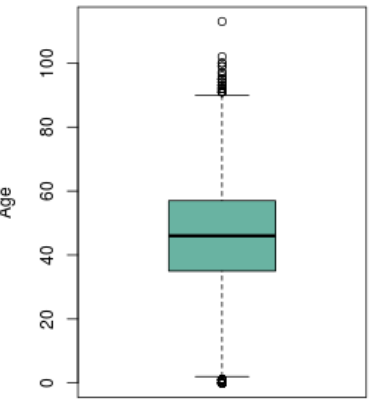
Figure 5. Boxplot of the distribution by age the population from all the territory with positive